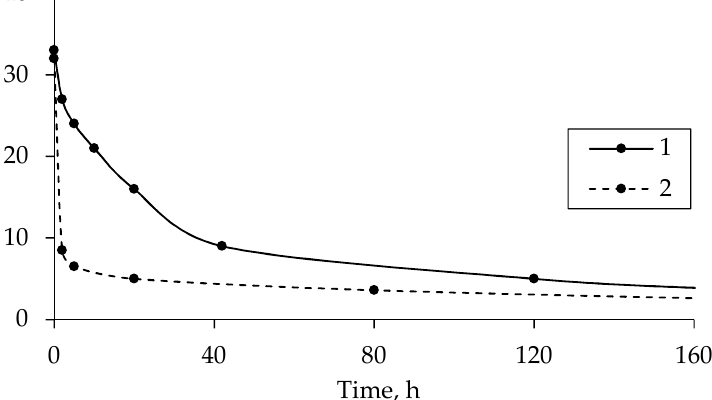
Figure 8. Time-dependent changes in the methane hydrate ( S h ) saturation of pure sand 1 (1) and sand 1 with 7% of kaolinite clay (2) (W = 10%) after the pressure dropped to 0.1 MPa at − 6.5 ◦ C. Black dots are experimental data; the solid line is a trend line of exponential approximation.